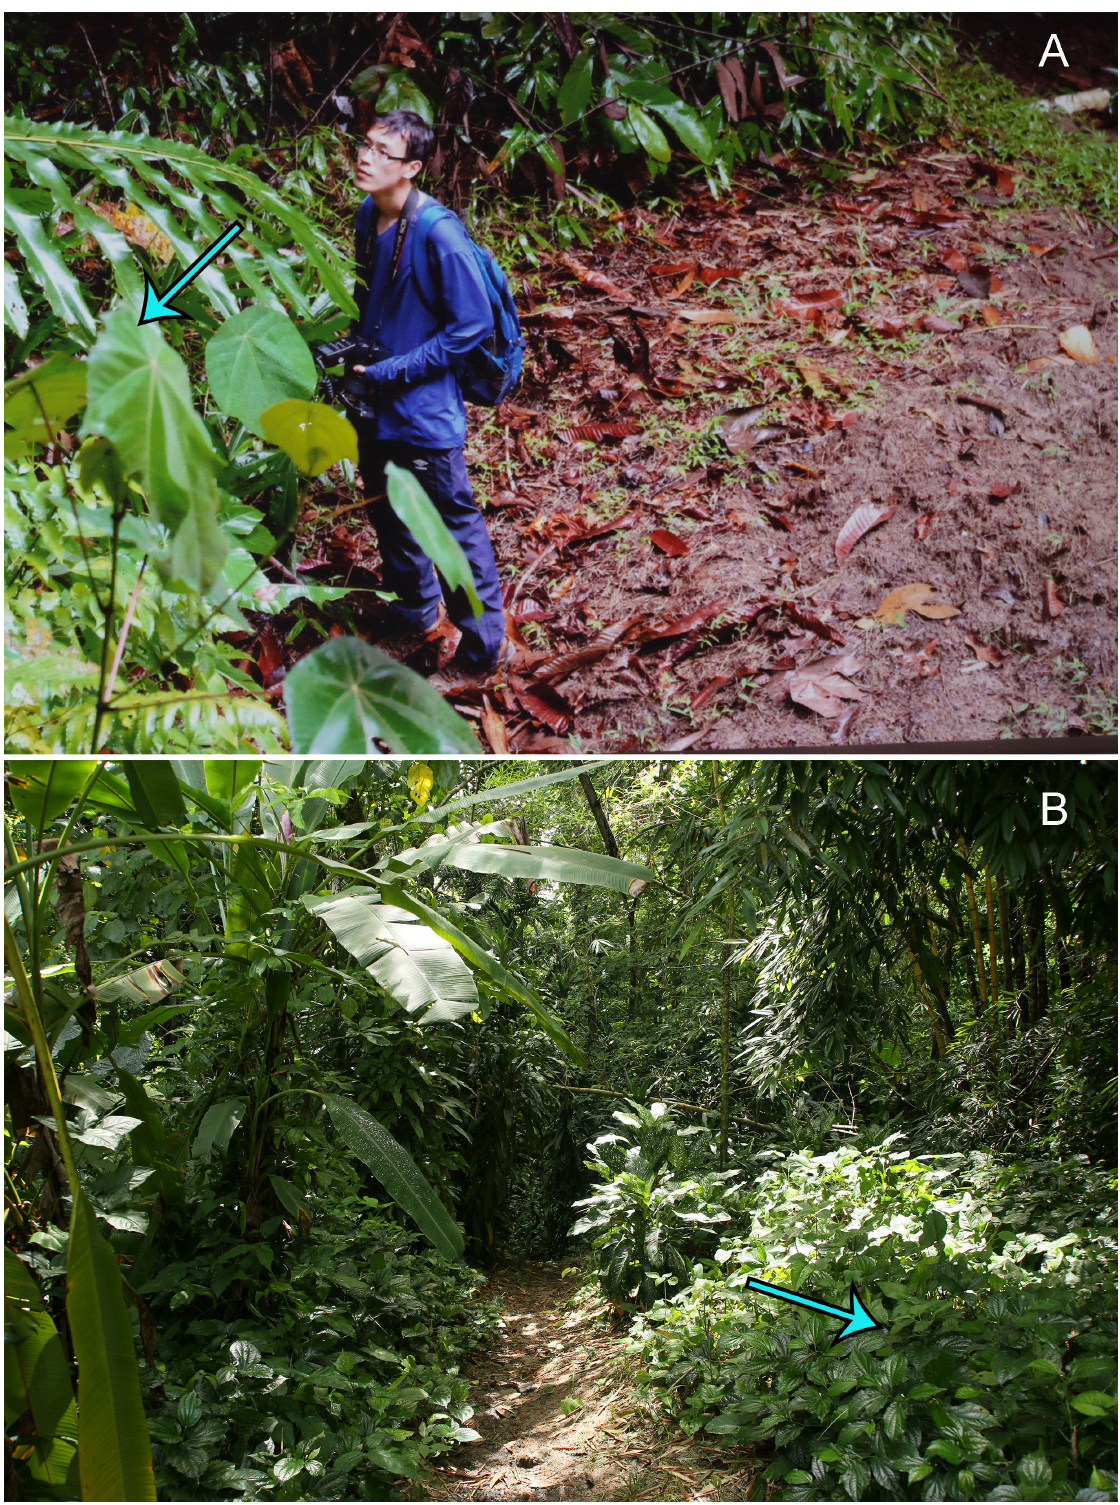
Fig. 27. A . Habitat where Nisitrus vittatus (Haan, 1844) can be found in Sungai Belalong in Brunei. B . Habitat where Nisitrus malaya Robillard & Tan sp. nov. can be found in Singapore. The arrows point at the type of plants ( Macaranga sp. in A, Piper sarmentosum Roxb. in B) on which Nisitrus can be found in relatively large numbers. Photograph credits: Yale-NUS students (A), Ming Kai Tan